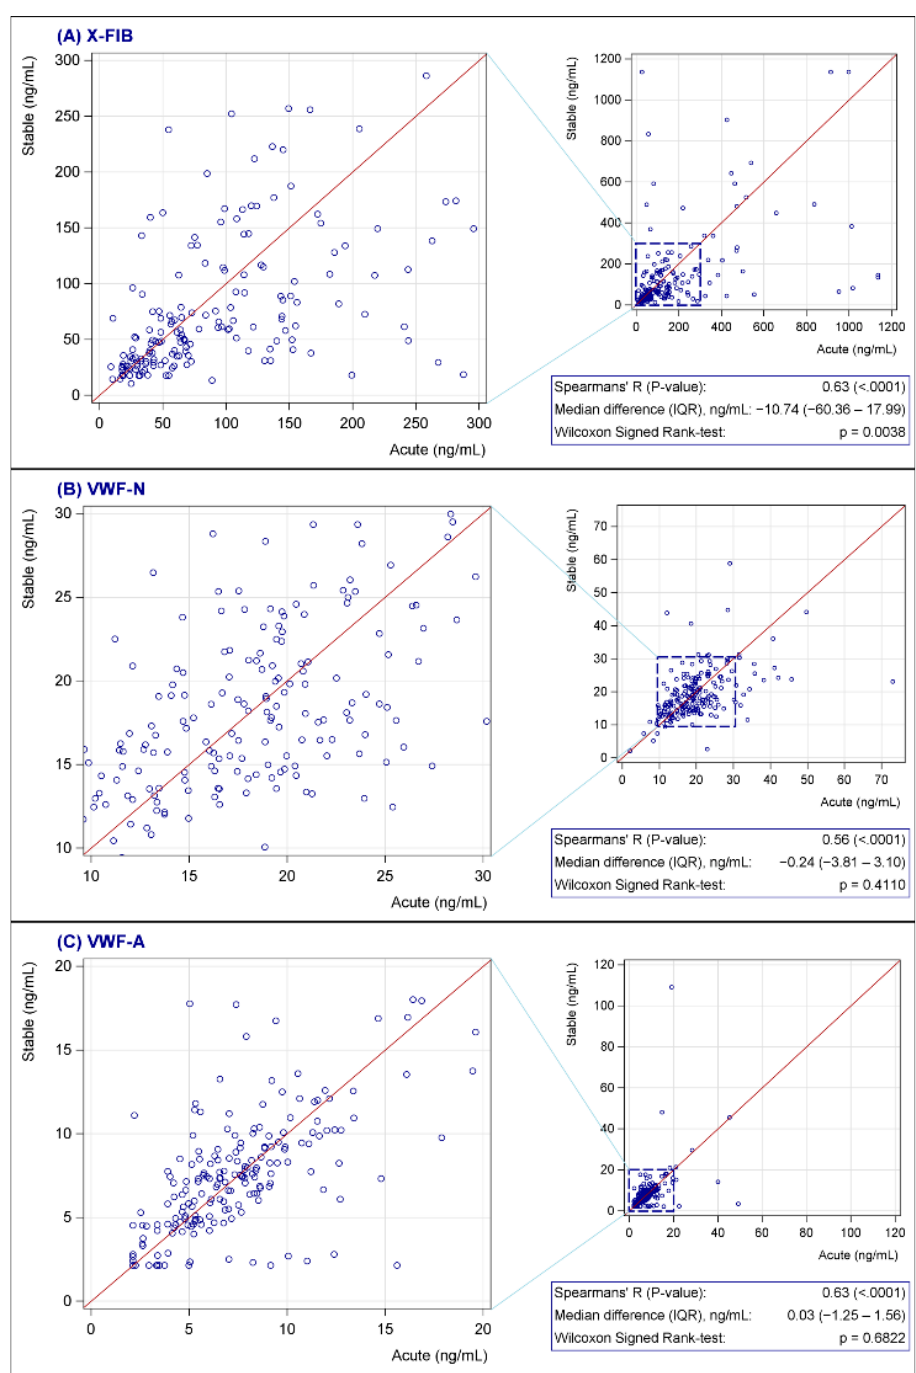
Figure 3. ( A – C ) Change in X-FIB ( A ), VWF-N ( B ), and VWF-A ( C ) from admission to follow-up. X- FIB: Cross-linked fibrin degeneration. VWF-N: N-terminal of von Willebrand Factor formation. VWF-A: Neoepitope of ADAMTS13-mediated activation of von Willebrand Factor. IQR: Interquartile range.